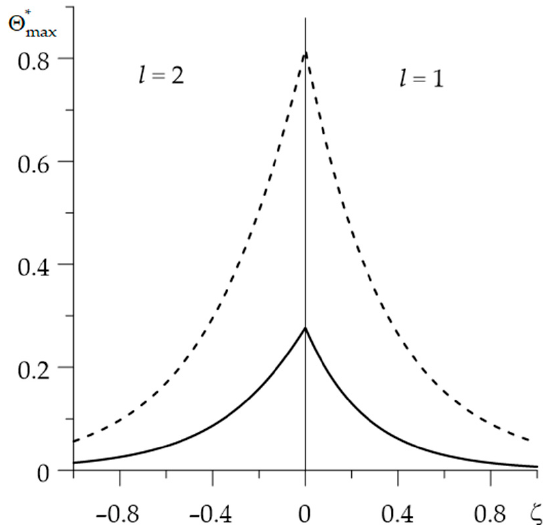
Figure 5. Distribution of the dimensionless temperature Θ ∗ max ( ζ ) = Θ ∗ ( ζ , τ max ) reached at the time moment τ = τ max along the distance ζ from the surface of friction with (solid lines) and without (dashed lines) taking into account the thermal sensitivity of the materials .